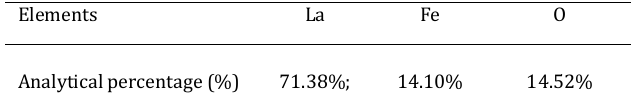
Figure 3: (a) Elemental mapping of LaFeO3 (b) EDX analysis of the calcined LaFeO3 with glucose/citric acid callcined at 400 °C for 2 h Table 1: The chemical composition of the BiFeO3.